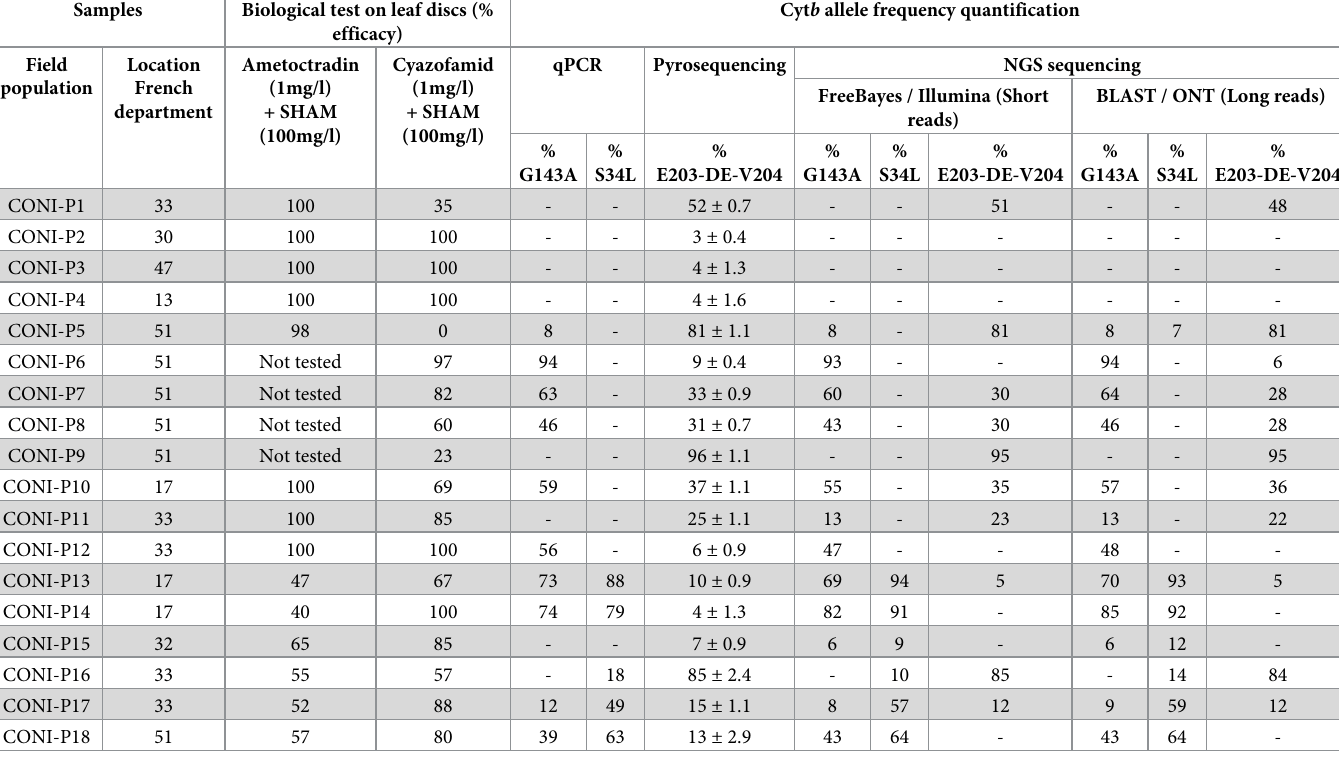
Table 3. Characterization of fungicide resistance of 18 field populations of P . viticola collected in French vineyards in 2020 (S3 Fig for map location).